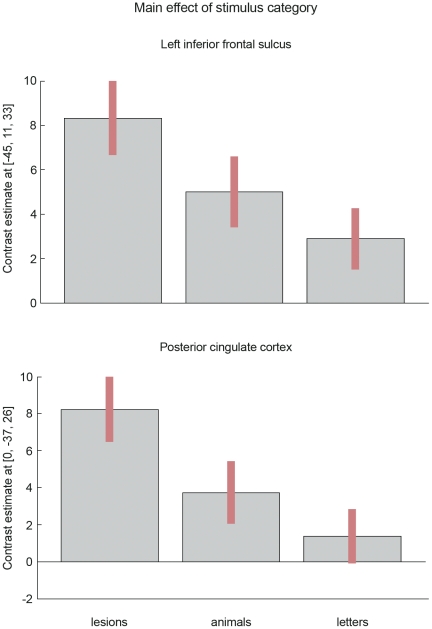
Contrast estimates* in cortical areas more active for diagnosing lesions#.* 90% confidence interval. # contrast [lesions>(animals and letters)] inclusively masked with lesions>baseline, lesions>animals, and lesions>letters at p = 0.001.